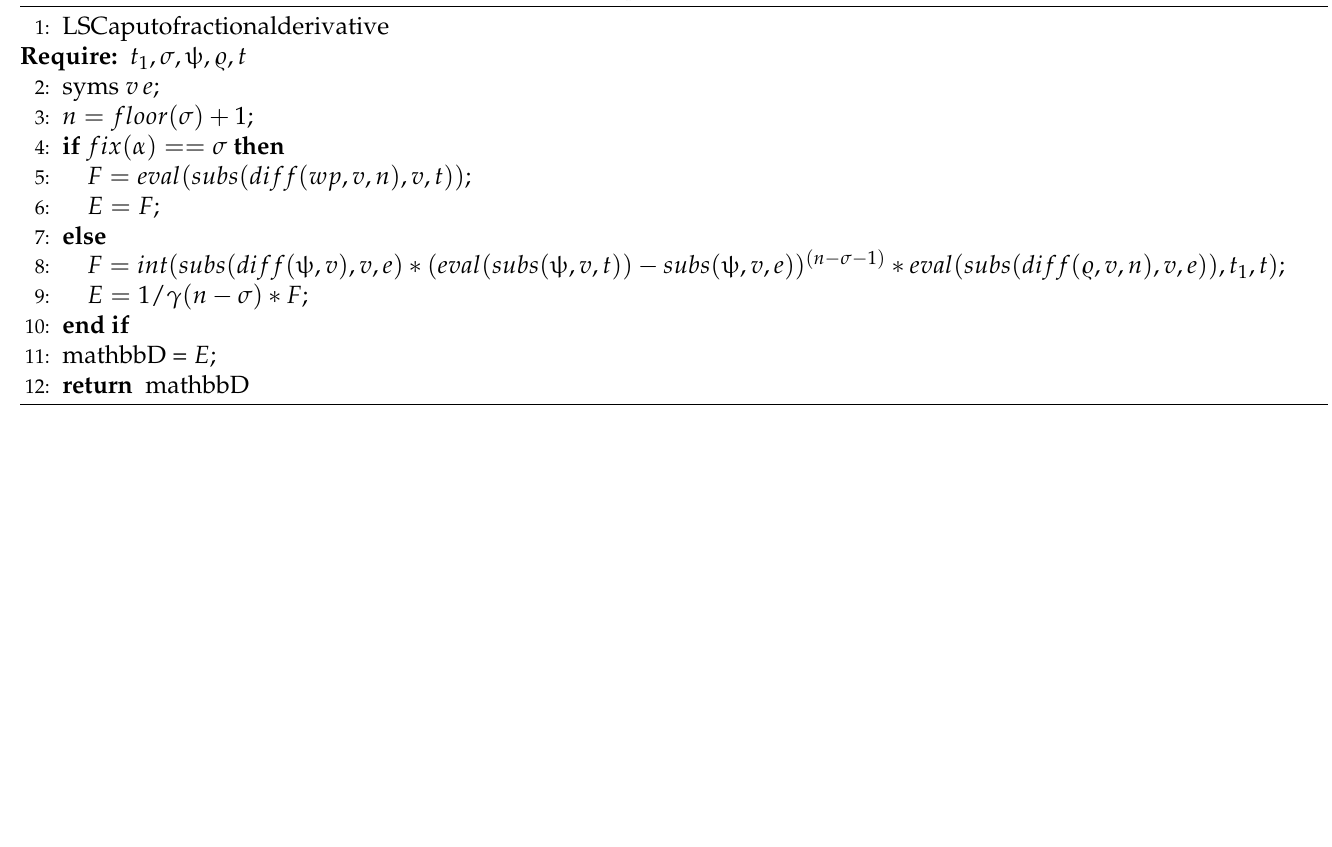
Algorithm A3 MATLAB lines for the calculation of C D σ ; ψ